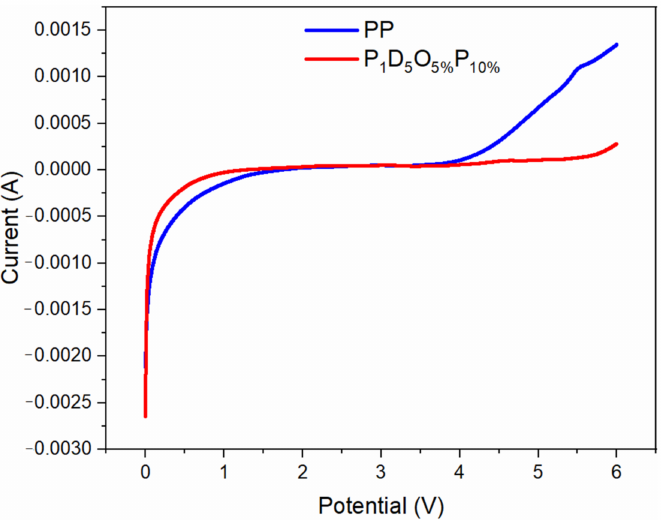
Figure 9. Linear sweep volt-ampere curve of membrane at room